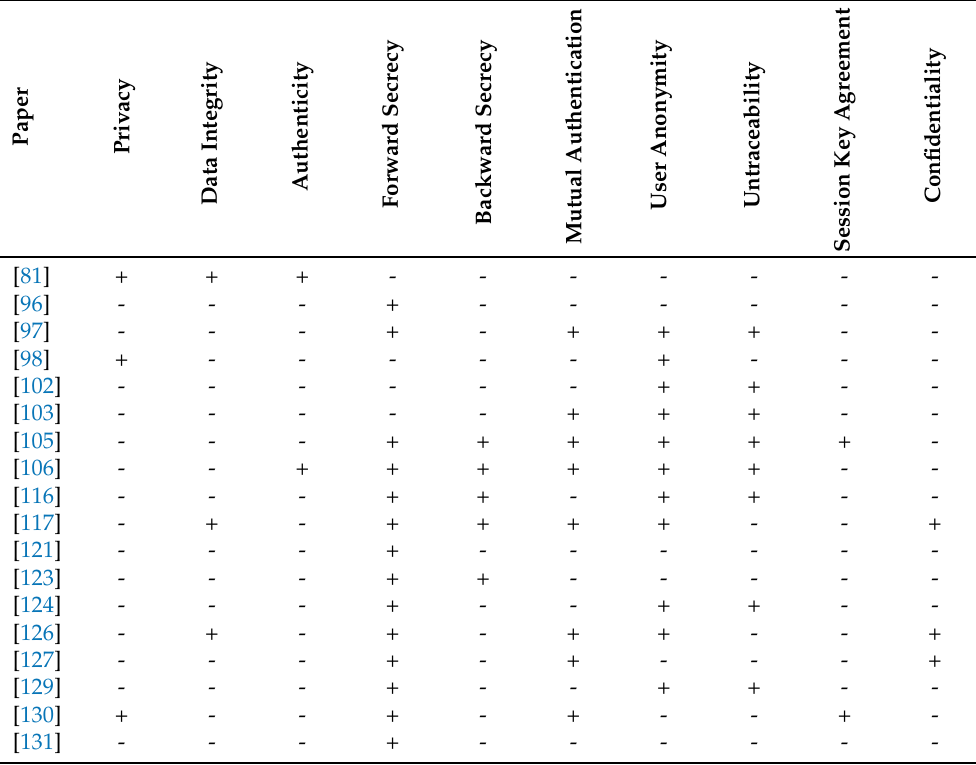
Table 5. The summary of security